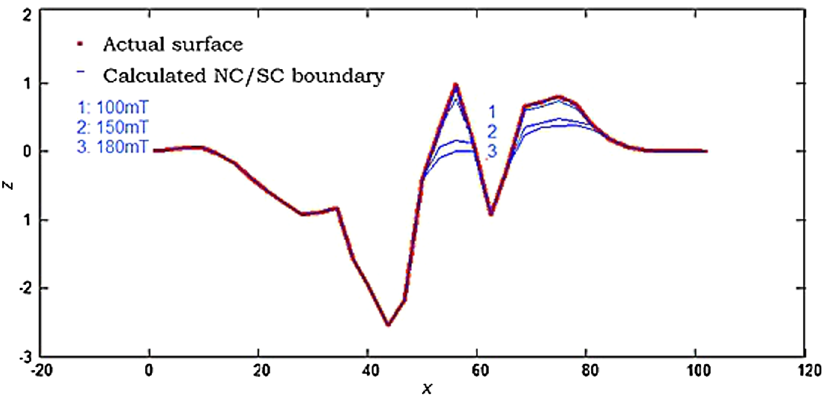
FIG. 7. Normal conducting phase fronts as calculated from different excited fields. Unit: μ